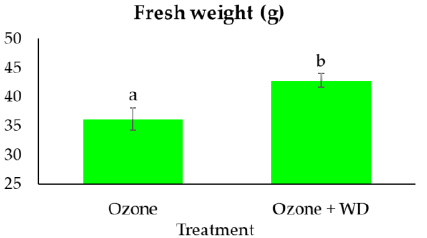
Figure 3. Fresh weight (mean ± standard error) of samples of Lactuca sativa after 30 days of fumigation with 60 ppb of O 3 in combination with (Ozone + WD) or without (Ozone) weekly foliar applications of 0.2% chestnut wood distillate. Different letters indicate statistically significant differences between treatments ( p -value < 0.05). Table 2. Expression of photosynthetic parameters (mean ± standard error) in samples of Lactuca sativa after 30 days of fumigation with 60 ppb of O 3 in combination with (Ozone + WD) or without (Ozone) weekly foliar applications of 0.2% chestnut wood distillate (WD).